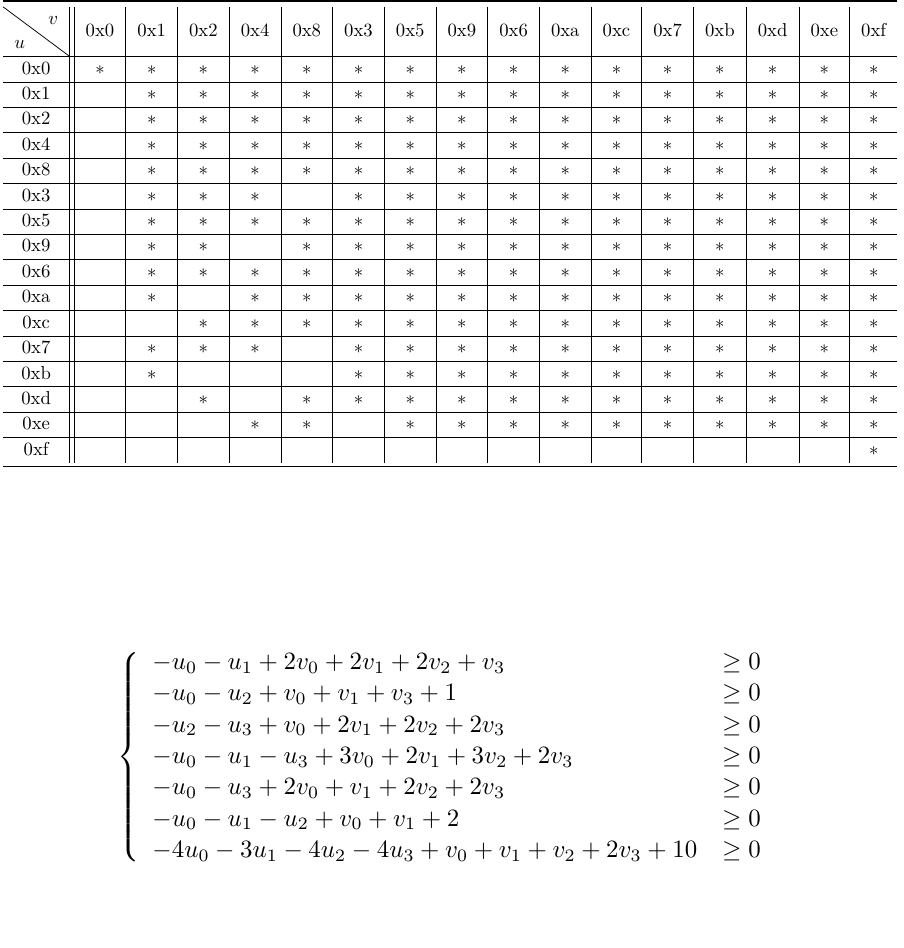
Table 14: The propagation of the division property for the S-box.